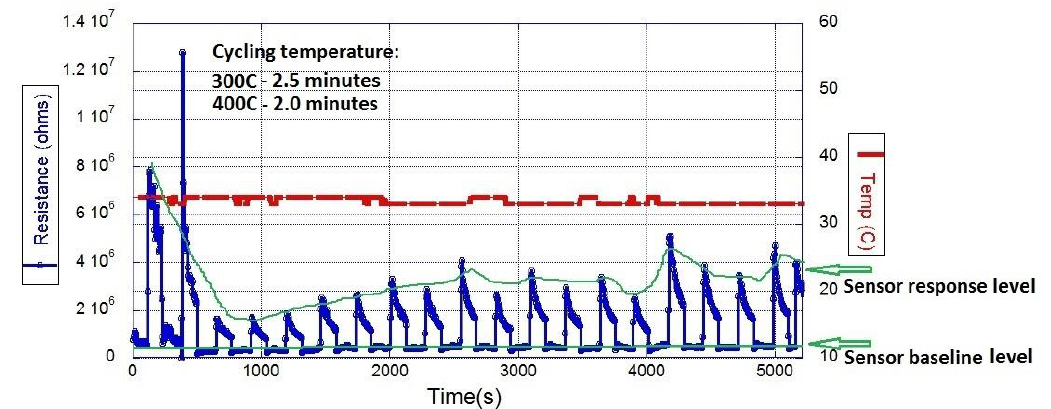
Figure 5. SnO 2 sensor response towards environmental gases in SERF, QUT, Brisbane, Australia.